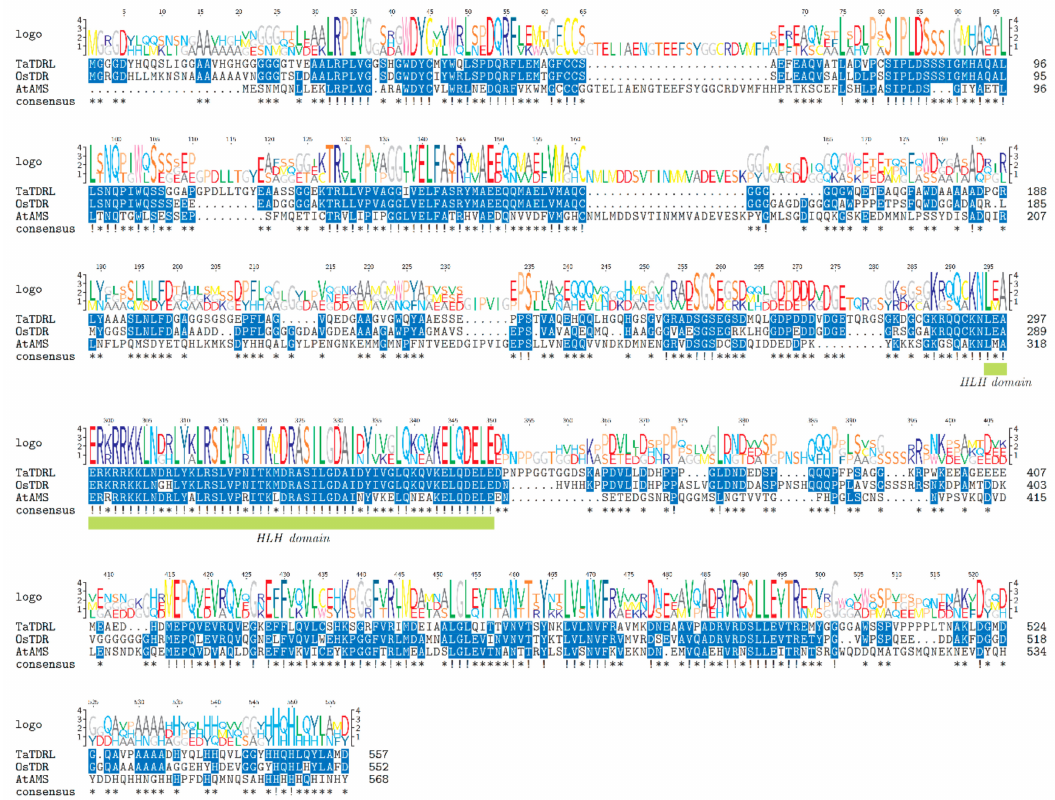
Figure 2. Protein sequence analysis of TaTDRL protein. Multiple alignment of TaTDRL and other basic helix-loop-helix (bHLH) domain proteins comprising Arabidopsis thaliana aborted microspores (AtAMS) and rice Oryza sativa L., Tapetum Degeneration Retardation (OsTDR). The highly conserved amino acid residues among the proteins examined are shaded. The solid green line shows the bHLH domain (295–344 aa).